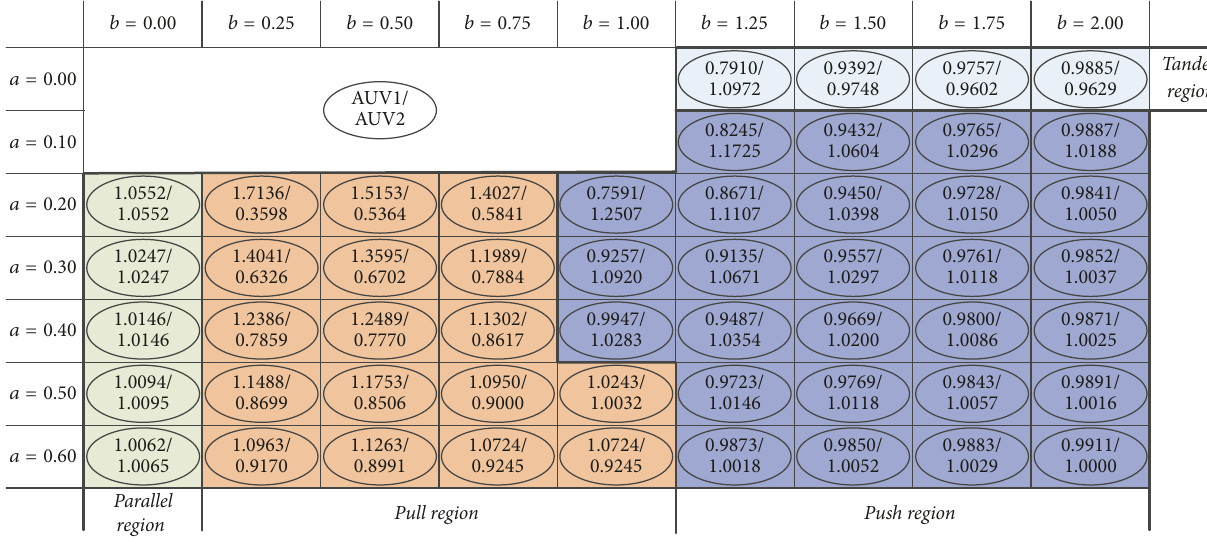
Figure 10: Drag ratios for different AUV fleet